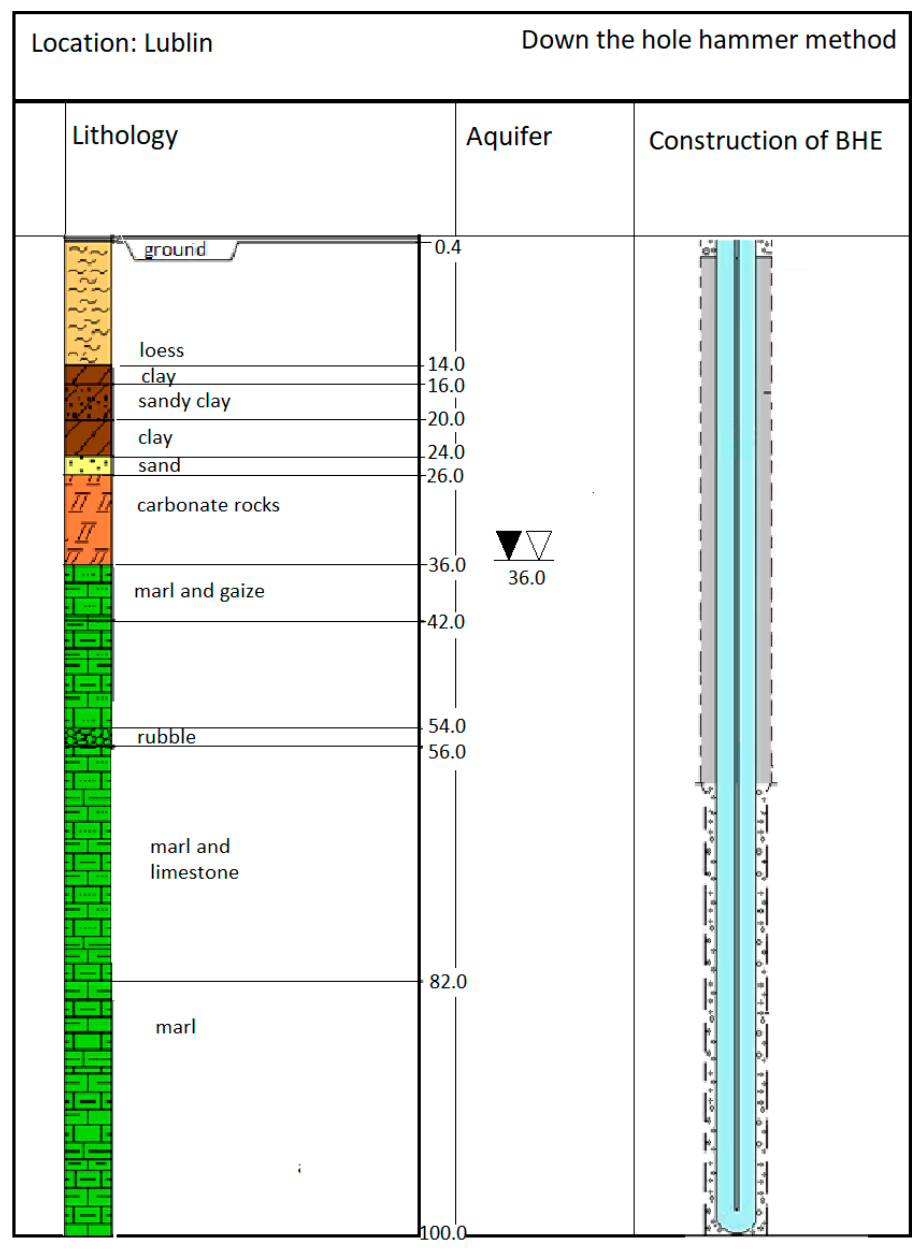
Figure 3. Geological profile and filtration schematics of the test borehole, which is common for every borehole under study [59].